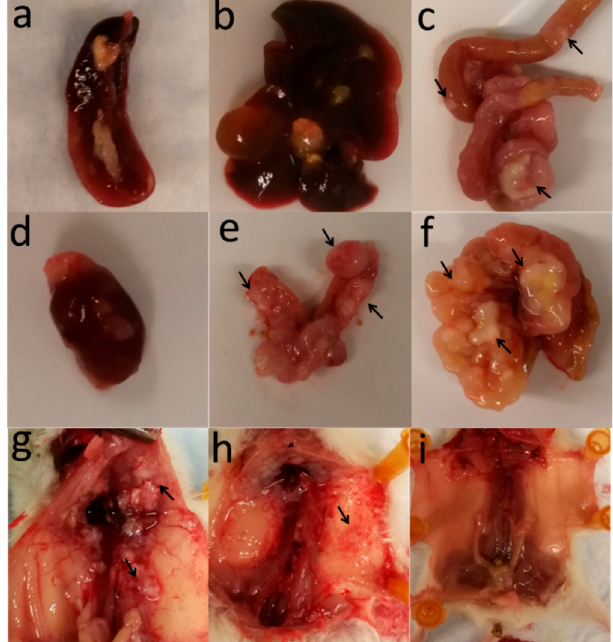
Figure 3. Intraperitoneal OVCAR8 luc model produced disseminated disease with tumor nodules in multiple organs including: ( a ) spleen; ( b ) liver; ( c ) small intestine; ( d ) kidney; ( e ) ovaries; ( f ) omentum; ( g ) diaphragm; and ( h ) peritoneal wall; ( i ) normal peritoneal cavity.